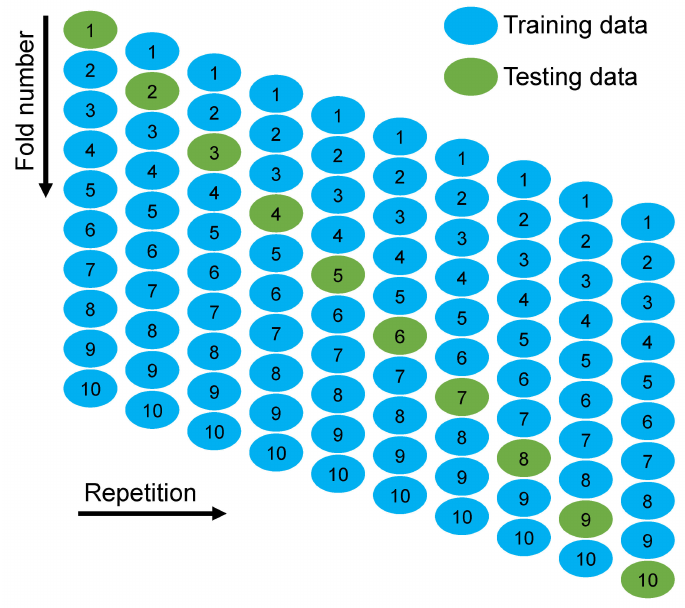
Figure 13. K-fold cross-validation procedure